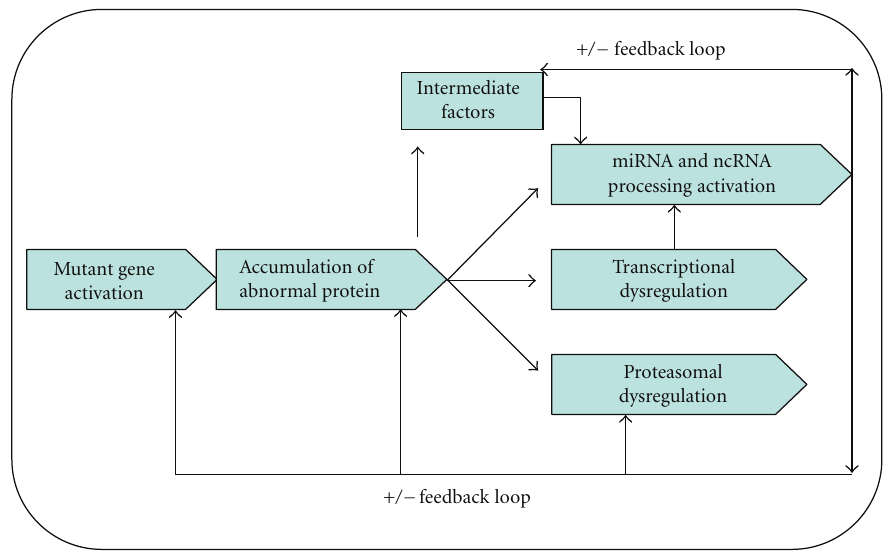
Figure 3: Model depicting miRNAs regulatory networks in the brain compartments a ff ected by neurodegenerative disorders and the potential protective feedback loops that operate during aging-induced functional